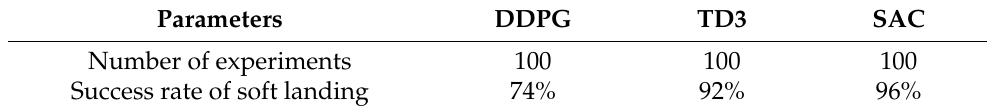
Table 5. Landing success